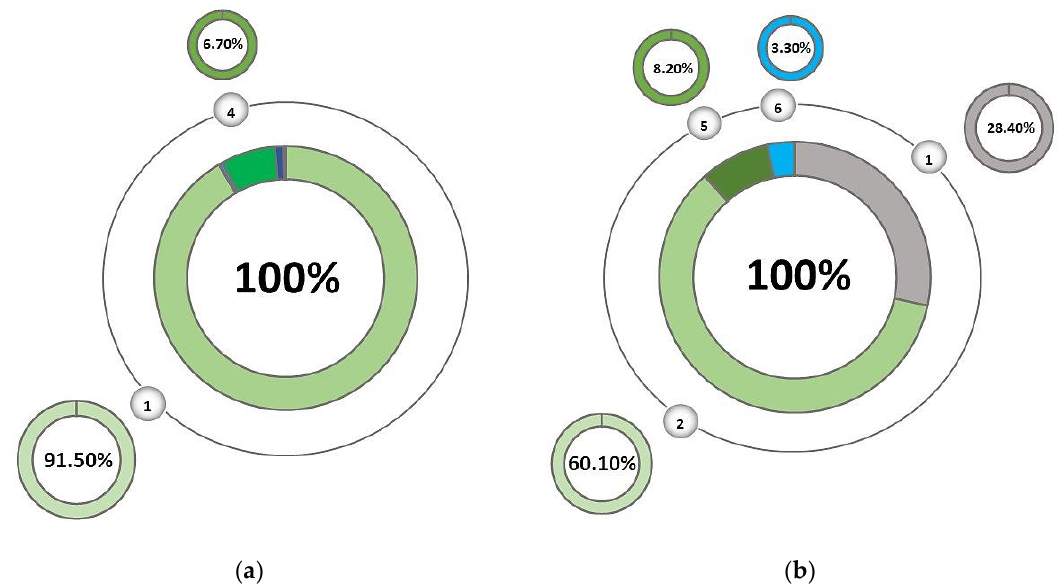
Figure 4. Graphical representation of results obtained by using a copper price equal to 3500 USD/ton, fixed bank ( a ) and fixed column ( b ).